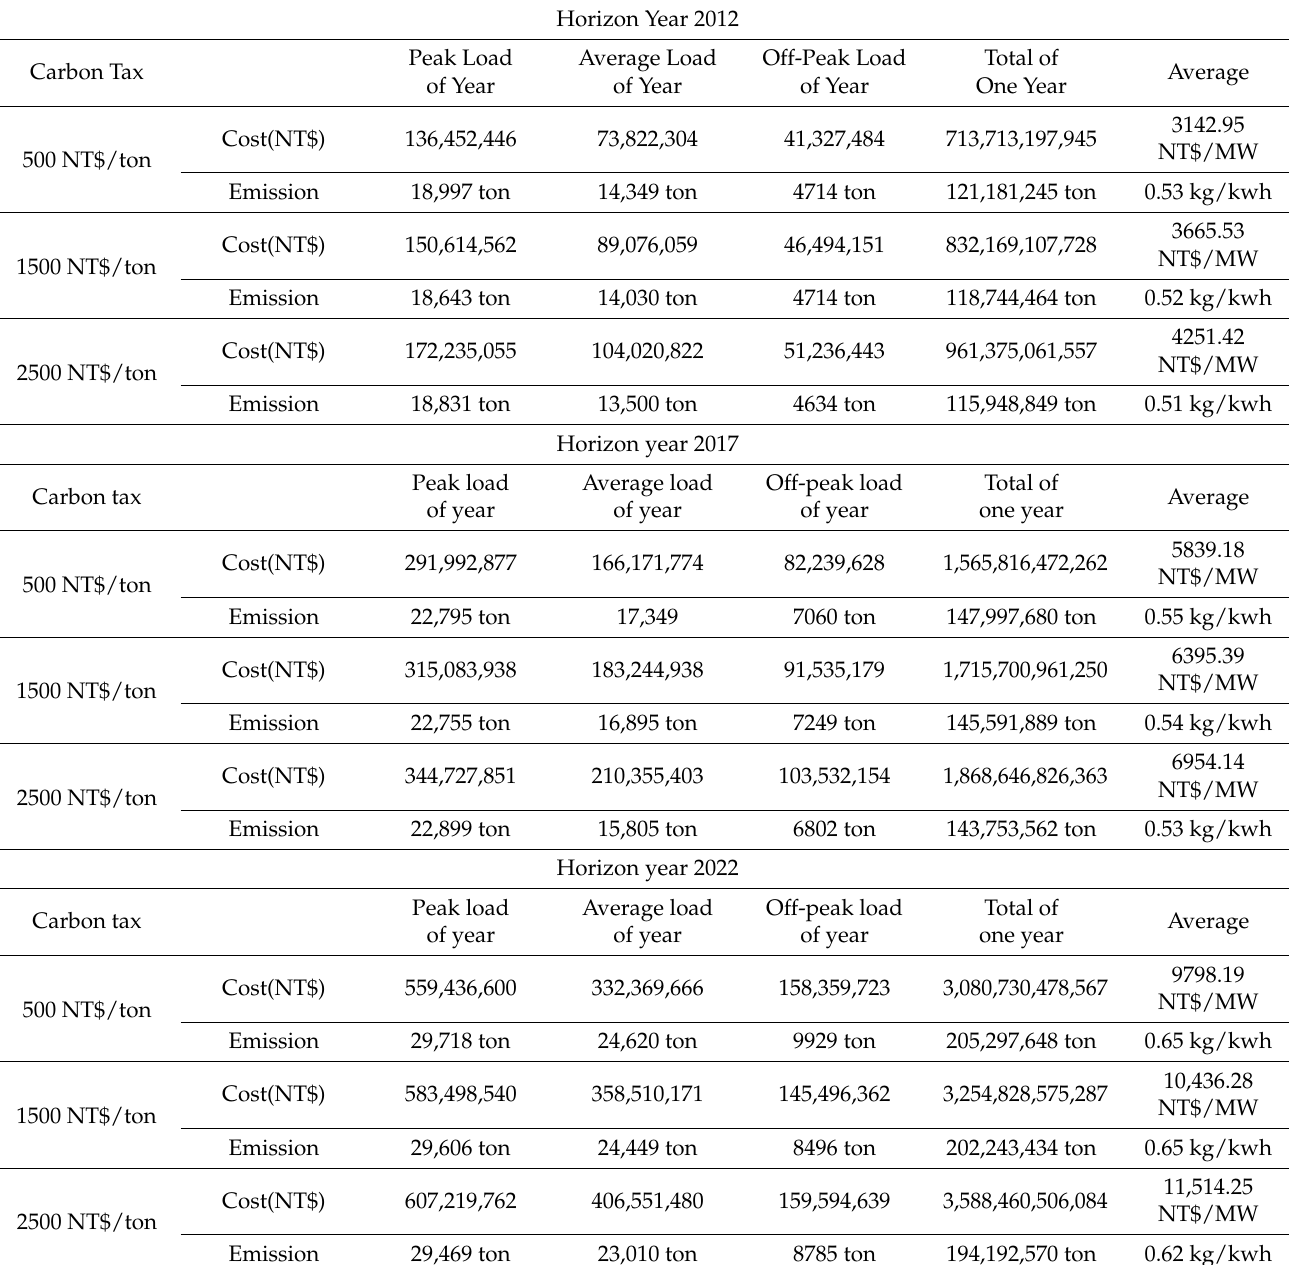
Table 3. The summary of the simulation results of Case